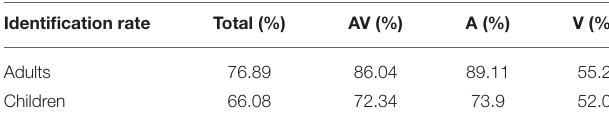
TABLE 1 | Identification rates for the perception of contrastive focus test, for different modalities, in adult, and child participants. Identification